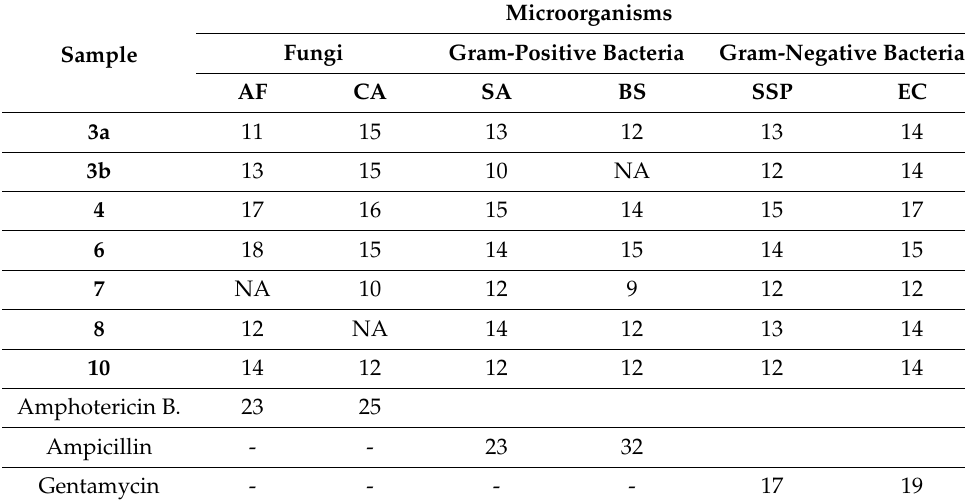
Table 4. The in vitro antimicrobial assessment of the synthesized compounds tested at 5 mg/mL using the inhibition zone assay (inhibition zone diameter in millimeters (mm)). Microorganisms Fungi Gram-Positive Bacteria Gram-Negative Sample